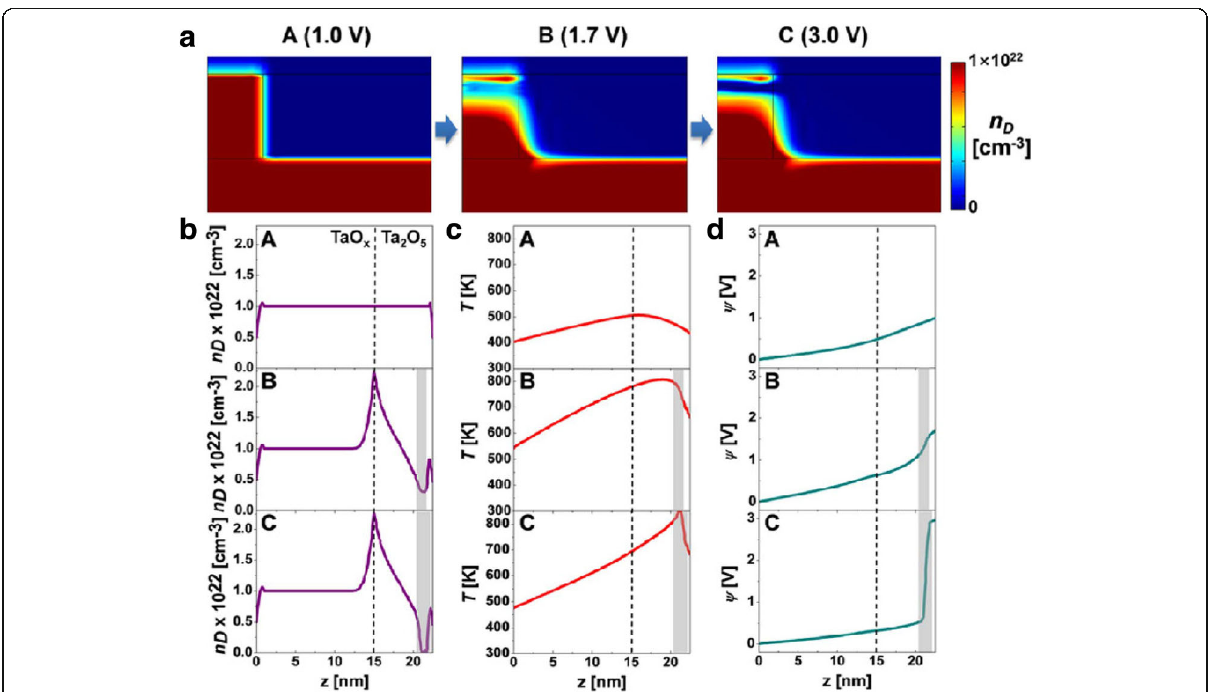
Fig. 11 Simulation results for the reset transition of the device. a V o density ( n D ) map. Calculated profiles of b n D , c T , and d y for states A (1.0 V), B (1.7 V), and C (3.0 V). The position of z = 15 nm indicates the Ta 2 O 5 /TaO x interface in the structure schematic. The shaded area shows the depleted gap, defined for n D < 5 × 10 21 cm -3